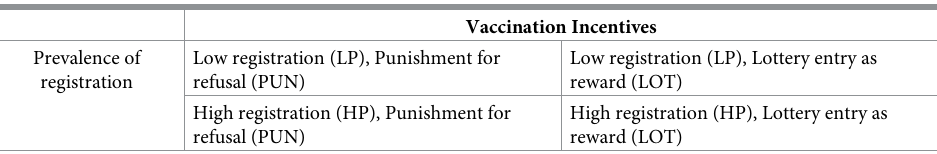
Table 1. Vignette